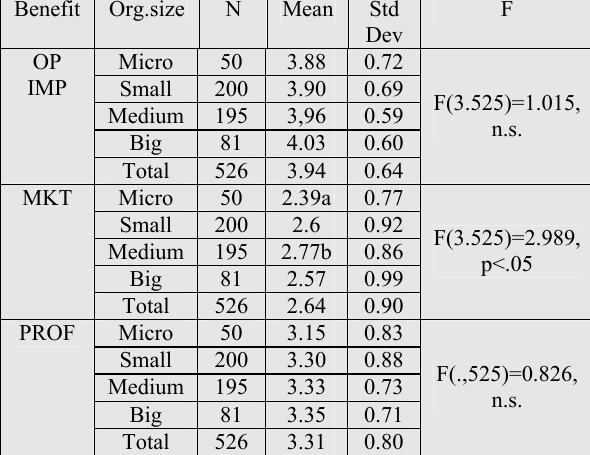
Table 3. ISO 9001 Benefits as a function of organizational dimension Benefit